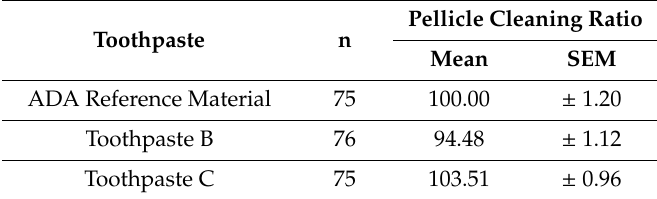
Table 2. Pellicle cleaning ratio of dentifrices. ADA = American Dental Association.